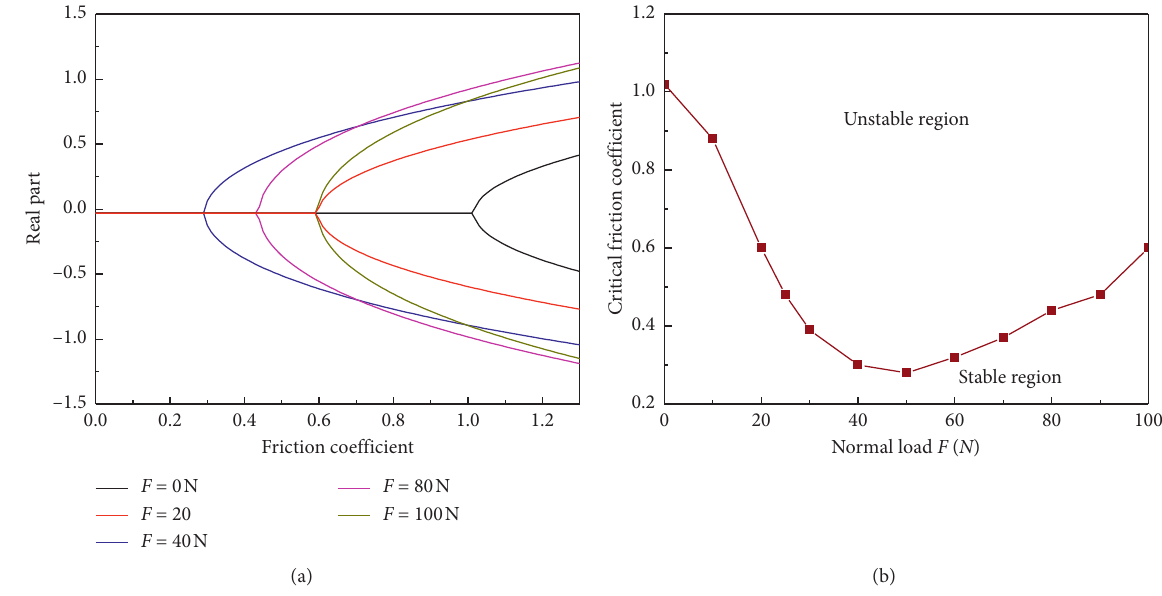
Figure 18: The real parts (a) and the critical friction coefficients (b) of the friction system at different normal loads.